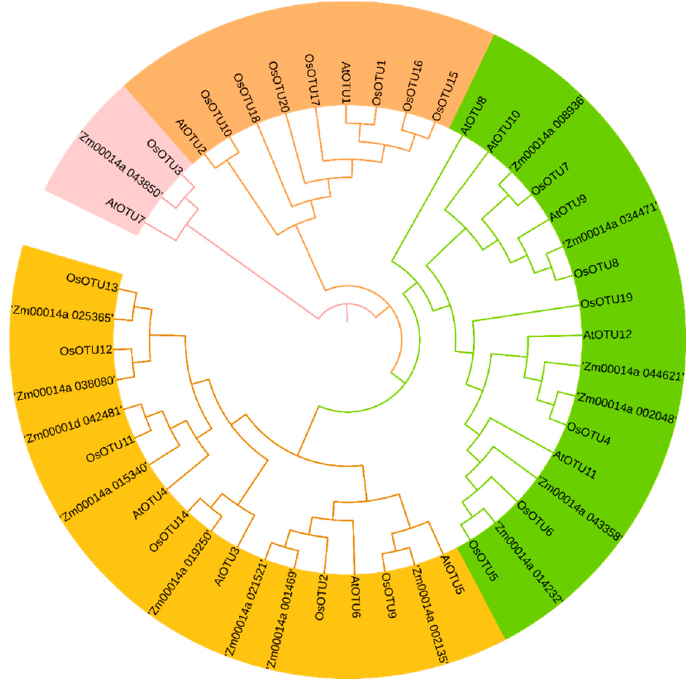
Figure 2. Phylogenetic analysis of OsOTU family proteins from Arabidopsis thaliana , Oryza sativa , and Zea mays . The phylogenetic tree was constructed using MEGA6.0 software by the neighbor-joining method with 1000 bootstrap replicates.